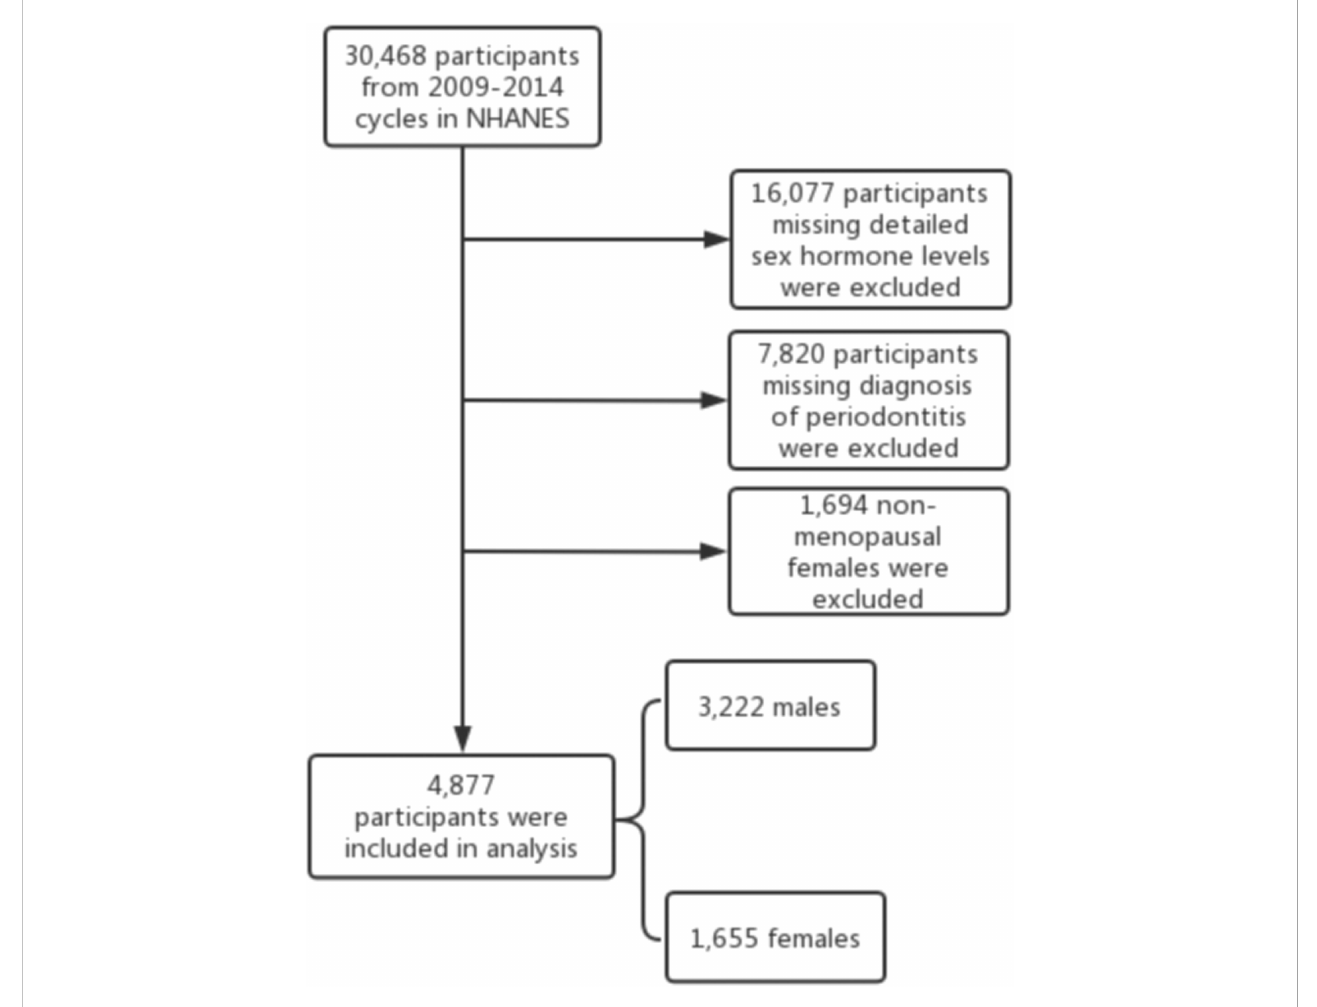
FIGURE 1 Flow chart of inclusion and exclusion criteria for our